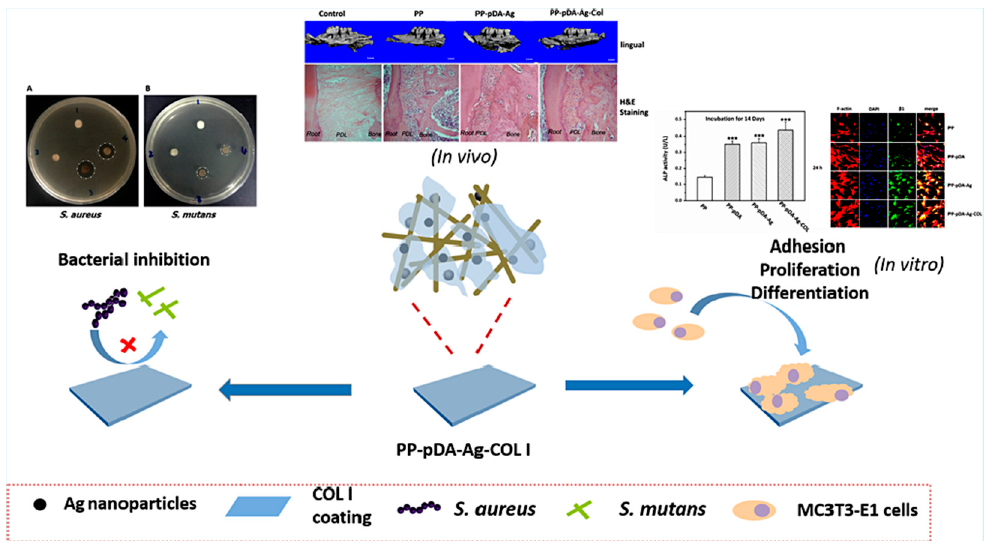
Figure 3. Biodegradable, synthetic scaffolds (poly(lactic-co-glycolic) acid (PLGA)/PCL blend (PP), silver-modified/collagen and polydopamine (pDA)) as materials used for the fabrication of oral and craniofacial guided tissue regeneration (GTR) materials. Reprinted with permission from Qian et al. 2019 [54], with permission from Copyright 2019 American Chemical Society.